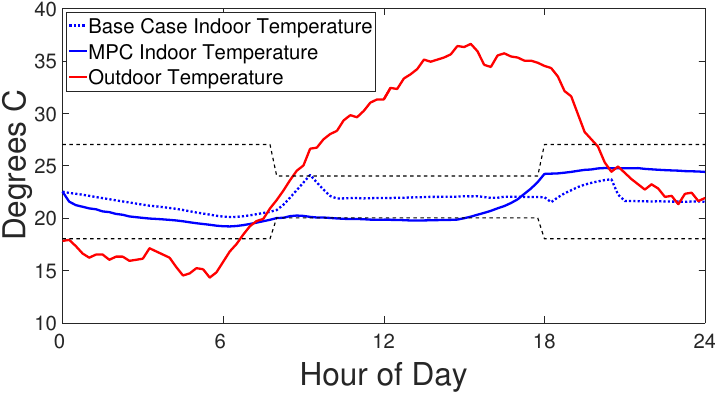
Figure 8. Indoor building temperature profiles under the rules-based control scheme and under the supervisory Peak Demand MPC with perfect forecasting, with upper and lower indoor temperature bounds (dashed black line), referenced with the ambient outdoor